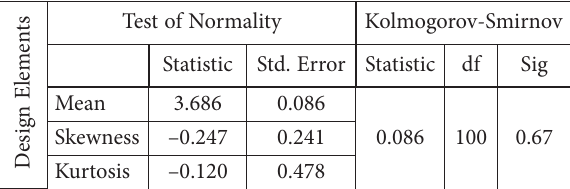
Table 2. Normality results of design elements scoring average